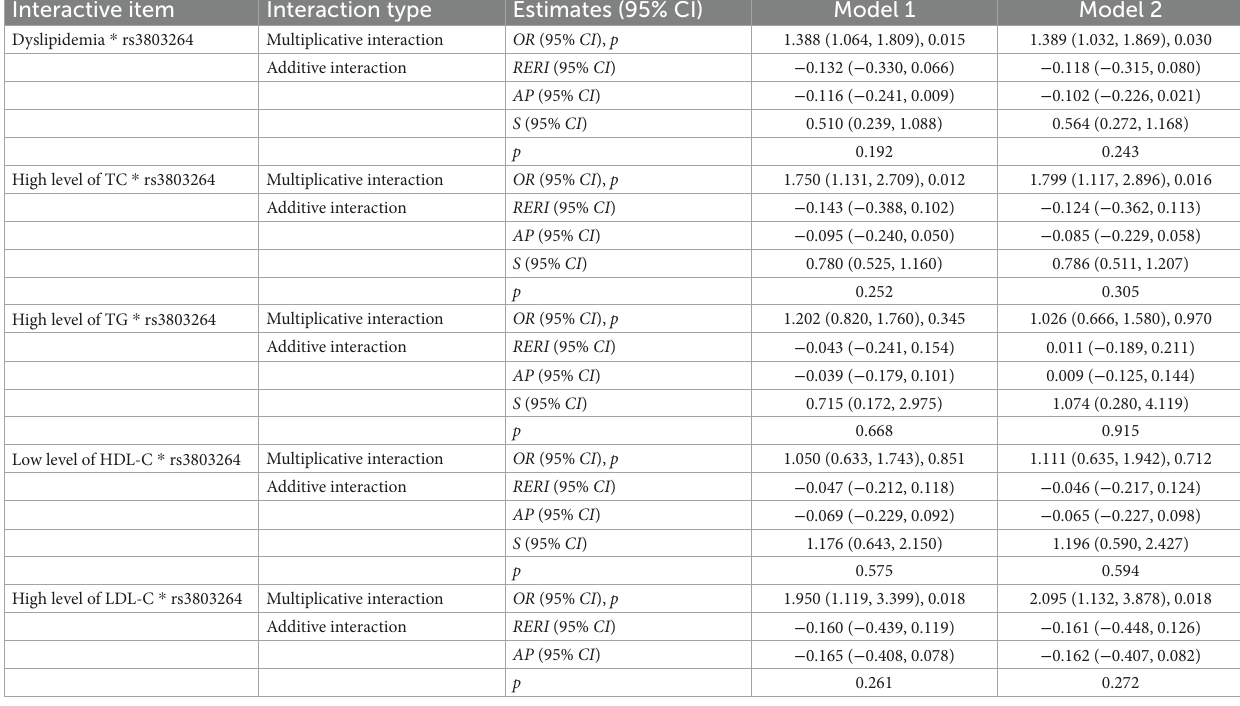
TABLE 4 Interaction analysis of THSD1 rs3803264 and dyslipidemia with the risk of hemorrhagic stroke in the case–control study. Interactive item